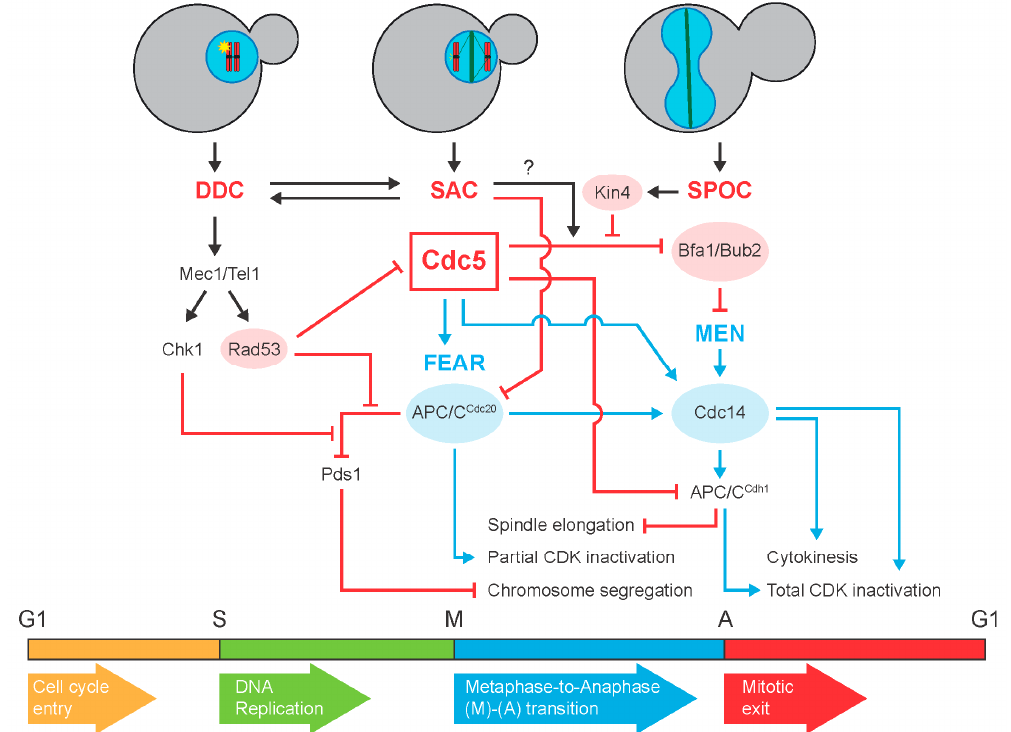
Figure 1. Diagram summarizing the main signaling pathways by which the DNA damage (DDC), the spindle assembly (SAC) and the spindle position (SPOC) checkpoints restrain cell cycle progression after their activation due to DNA lesions (depicted as a yellow star), unattached chromosomes (marked with yellow lines emanating from the unbound kinetochore) or an incorrect spindle alignment, respectively. The scheme also outlines the interplay between these surveillance mechanisms and the polo-like kinase Cdc5 to ensure the integrity and the even distribution of the duplicated genome during mitosis. Interactions are indicated by lines that end in an arrow when positive or in a bar when negative. Blue lines and red lines highlight, respectively, positive and negative signaling events that are important for the regulation of mitotic exit by the cell cycle checkpoints. FEAR: Cdc-fourteen early anaphase release; MEN: mitotic exit network.